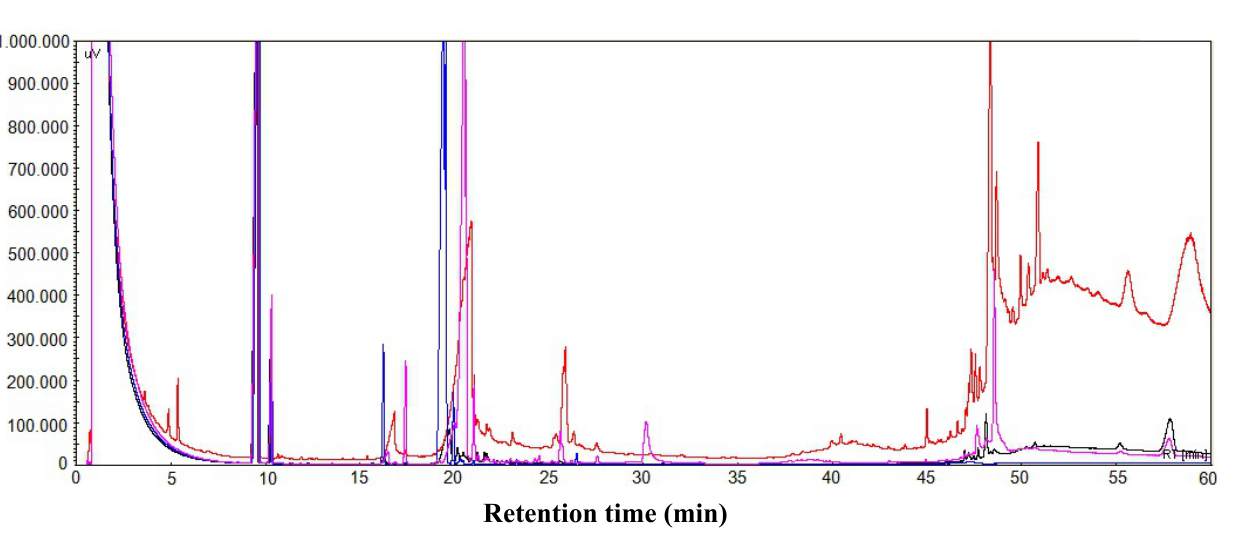
Figure 1. Different chromatograms obtained in the alcoholysis of sunflower oil with methanol (FAME), ethanol (FAEE) and glycerol (monoacyl glycerols, MG), corresponding to blue, pink, and red, respectively. In black is the initial sunflower